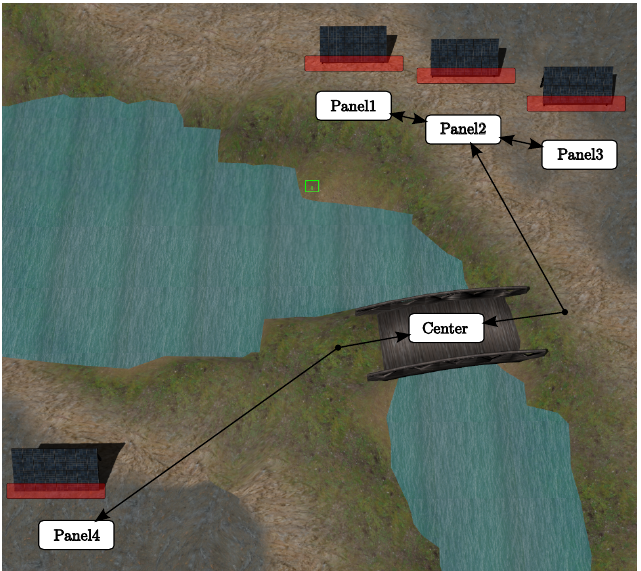
Figure 12. Solar farm Gazebo world with the topological map overlapped. The red rectangles represent the area that must be covered to ensure a reliable solar panel